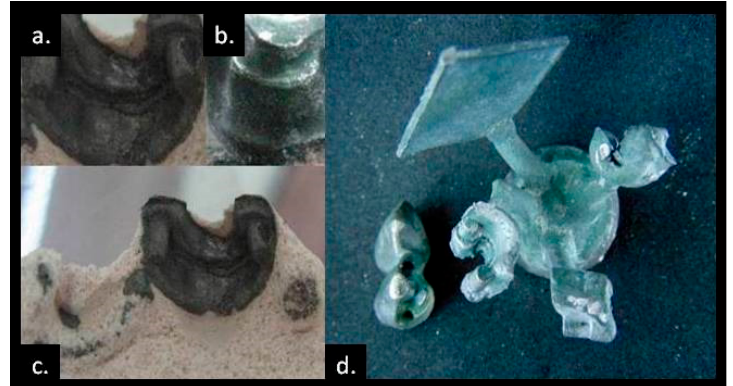
Figure 11. ( a , c ). The assembly surface of the Pb + framework after detachment from the mold; ( b ). The assembly surface of the Pa framework after detachment from the mold; ( d ). Casting of Pb frameworks, made by different methods and Pa insert framework.